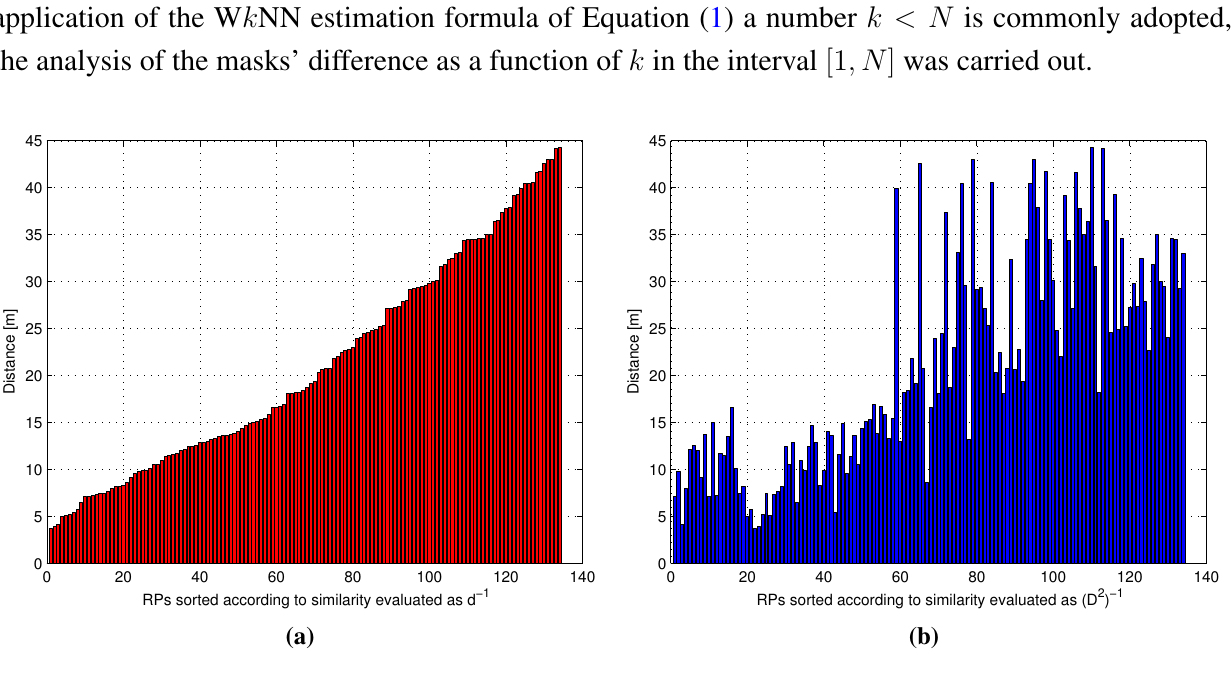
Figure 1. Example of reference point (RP) masks obtained for a specific test point (TP). ( a ) M , ( b ) M i,ideal i, ( D 2 ) − 1